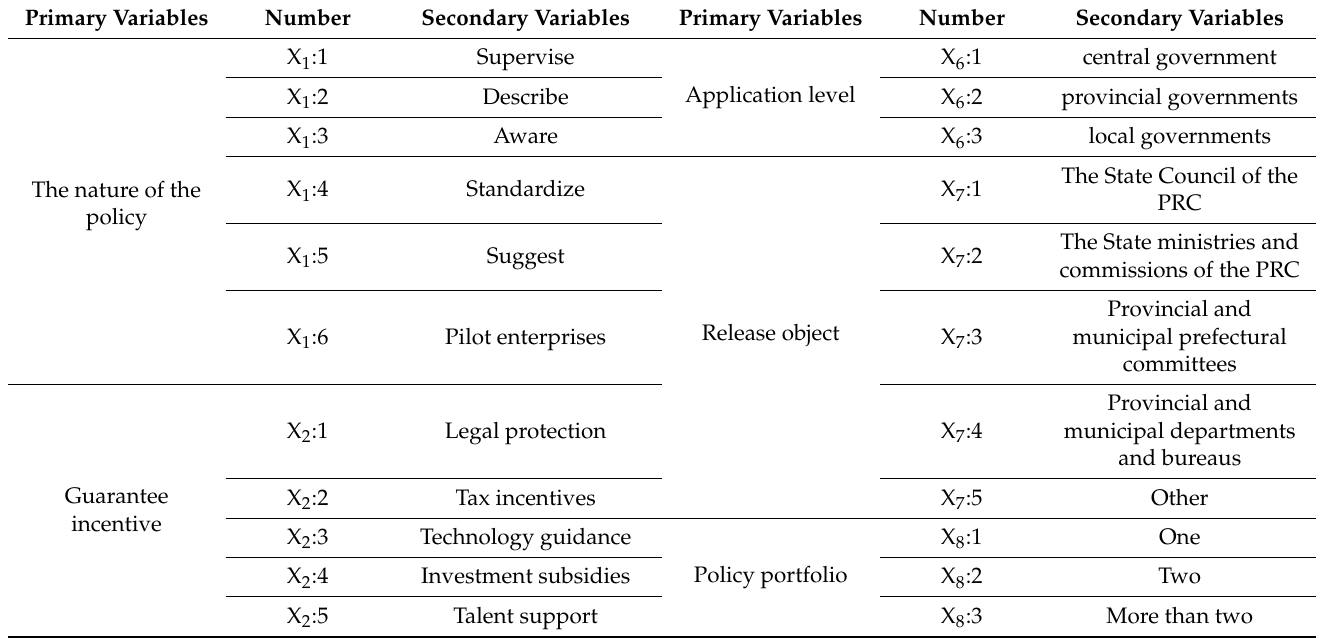
Table 4. Variable classification of the PMC index